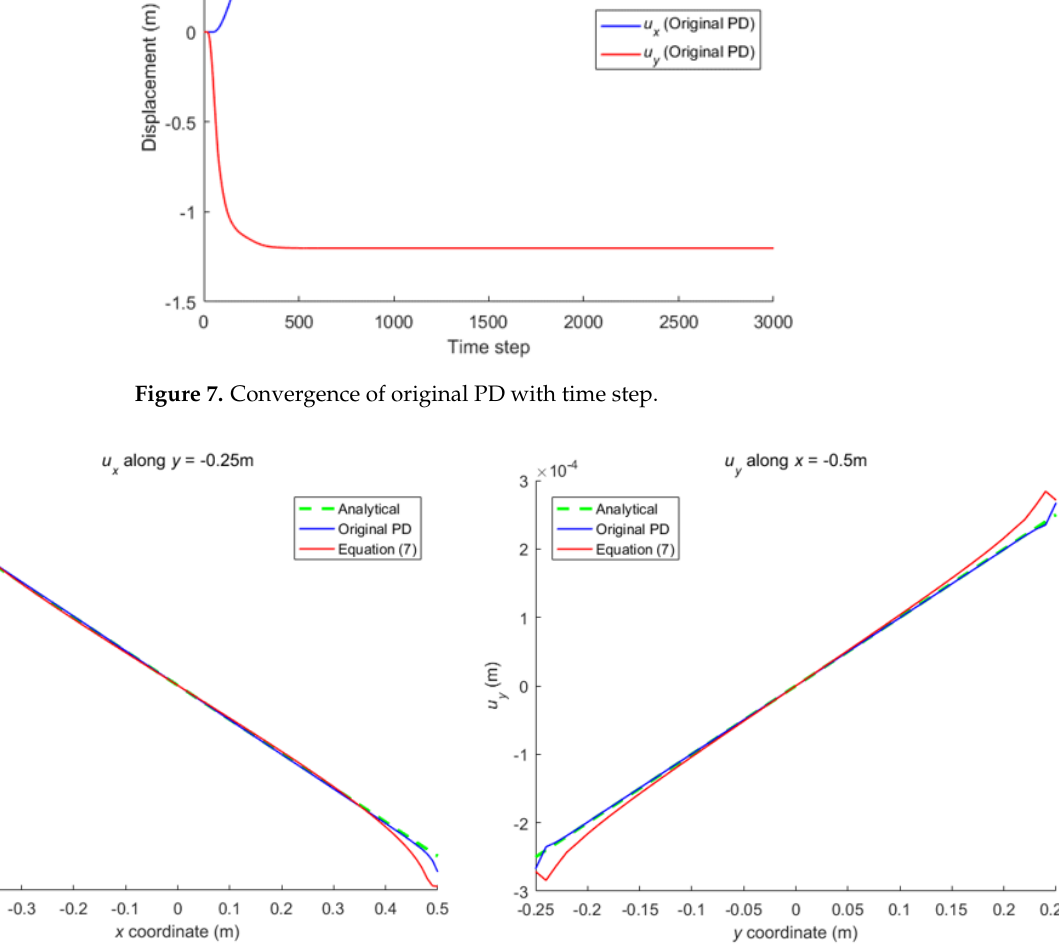
Figure 9. The displacement along central lines of the rectangular plate subjected to tension: ( a ) u x along y = 0; ( b ) u y along x = 0. ( a )